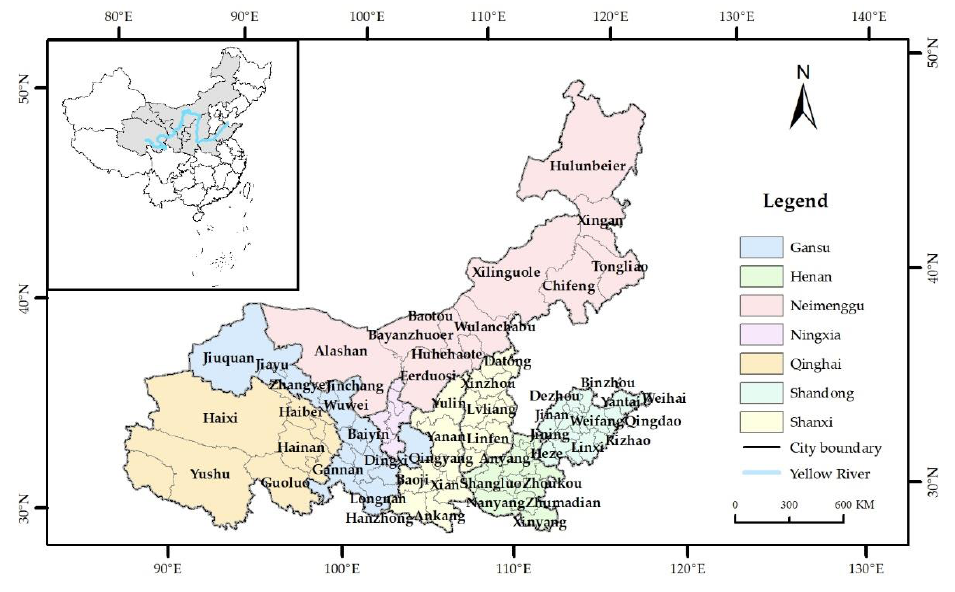
Figure 1. Location of the study area.